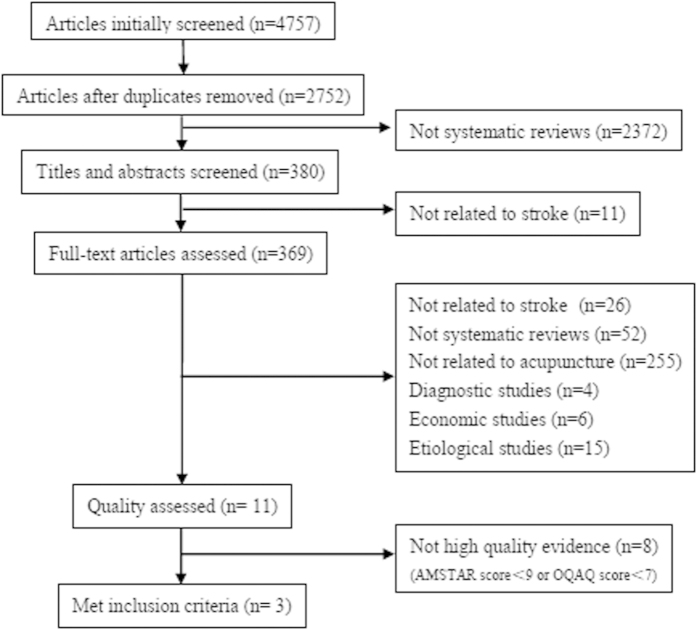
Flowchart: study selection.